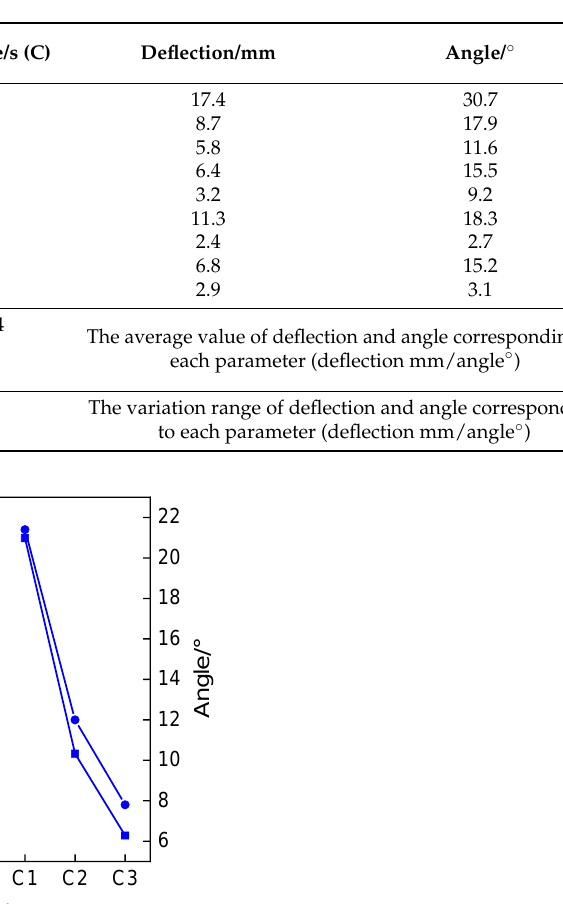
Table 4. Results of the orthogonal experiment.